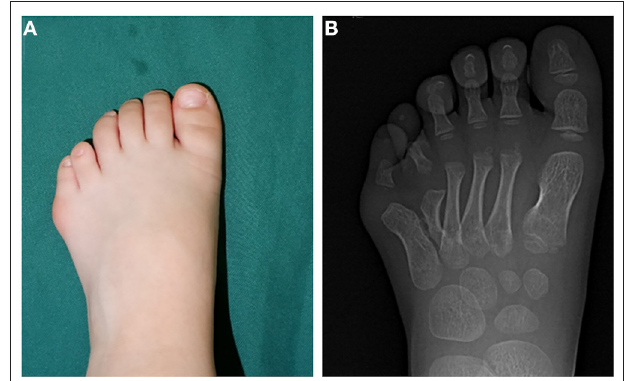
FIGURE 1 | Preoperative morphological and imaging features. (A) Preoperative photos depicting the appearance of the affected foot. (B) Preoperative radiograph showing malformed fifth metatarsal and wide forefoot.